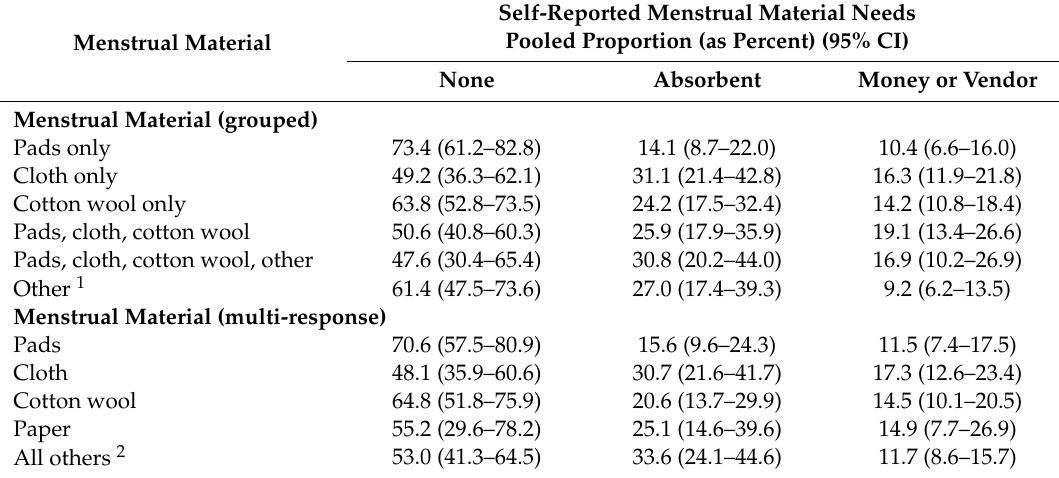
Table 2. Pooled proportion of menstrual material needs by the type of menstrual material used.